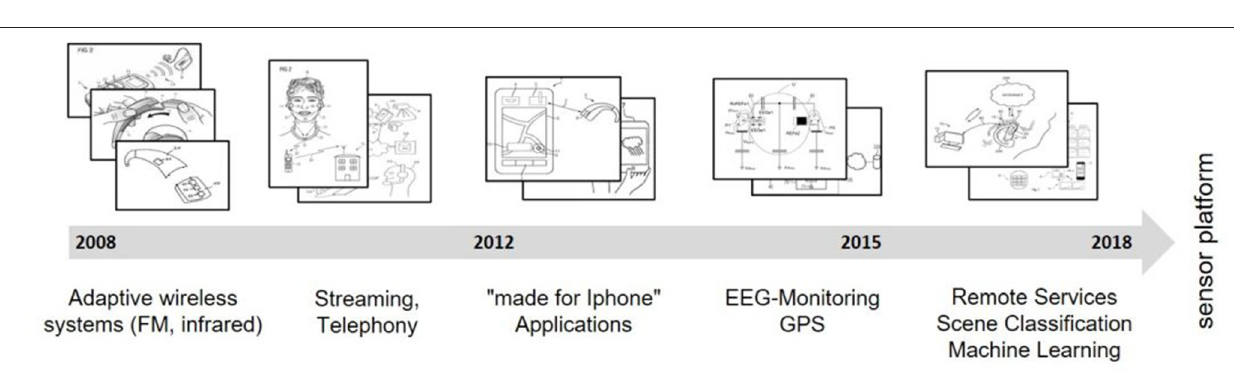
FIGURE 3 | Evolution of the technological trends in the field of